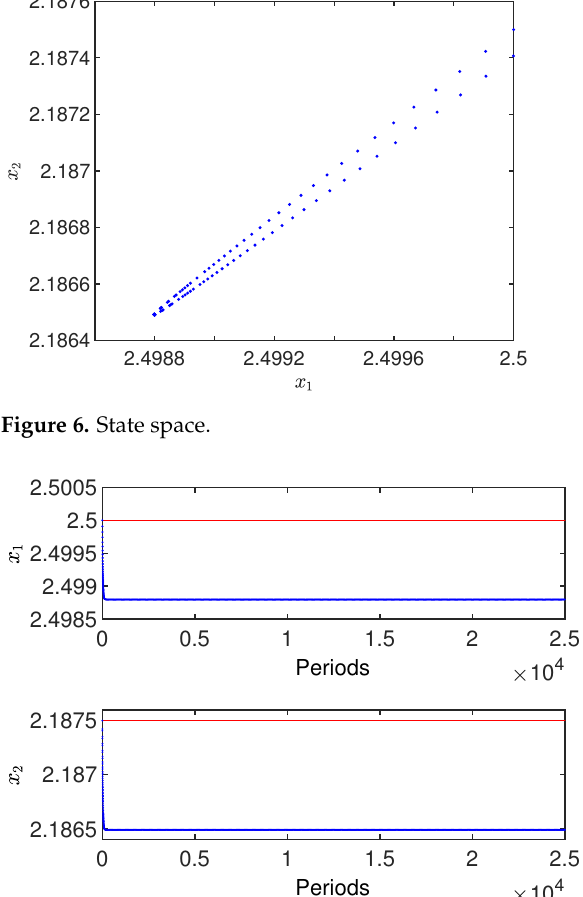
Figure 7. Behavior of the voltage and current regulation.